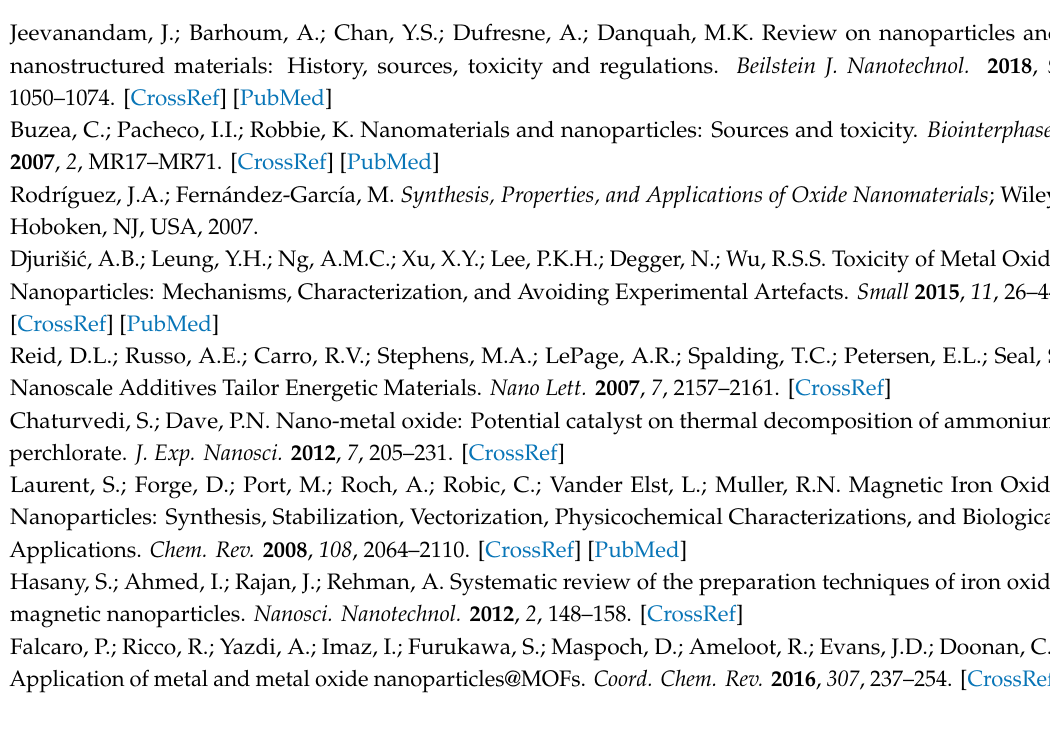
Table S1. List of physicochemical, molecular and atomistic (computational) and assay descriptors used for model development.; Figure S1. The workflow picture for the full-particle structural and energetic nanodescriptor simulation. Overview of Correlation based Feature Selection method combined with the BestFirst evaluator applied to the dataset, which identified the 7 most significant descriptors that were used for model development(S1); Documenting the model using the MODA template (S2); QSAR model report following OECD template